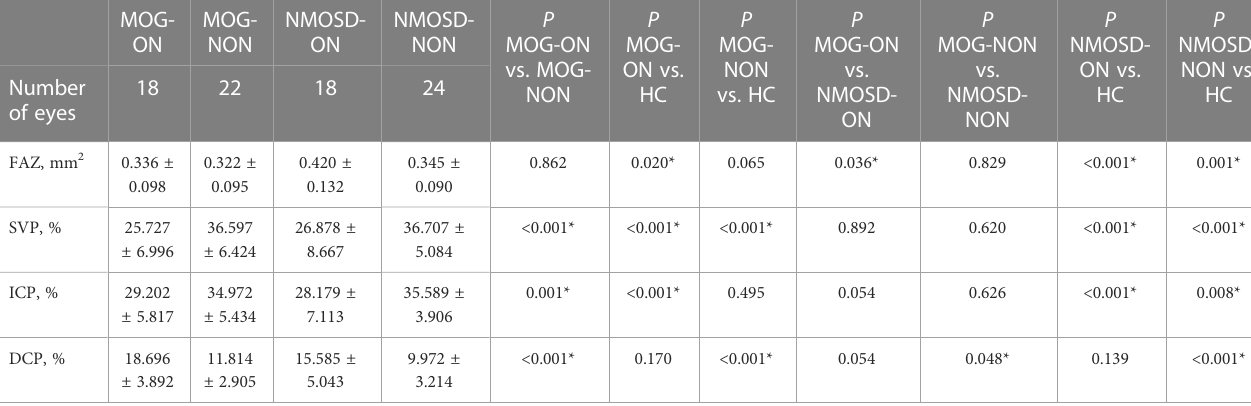
TABLE 3 OCTA results in MOGAD and NMOSD patients strati fi ed by history of ON. MOG- ON